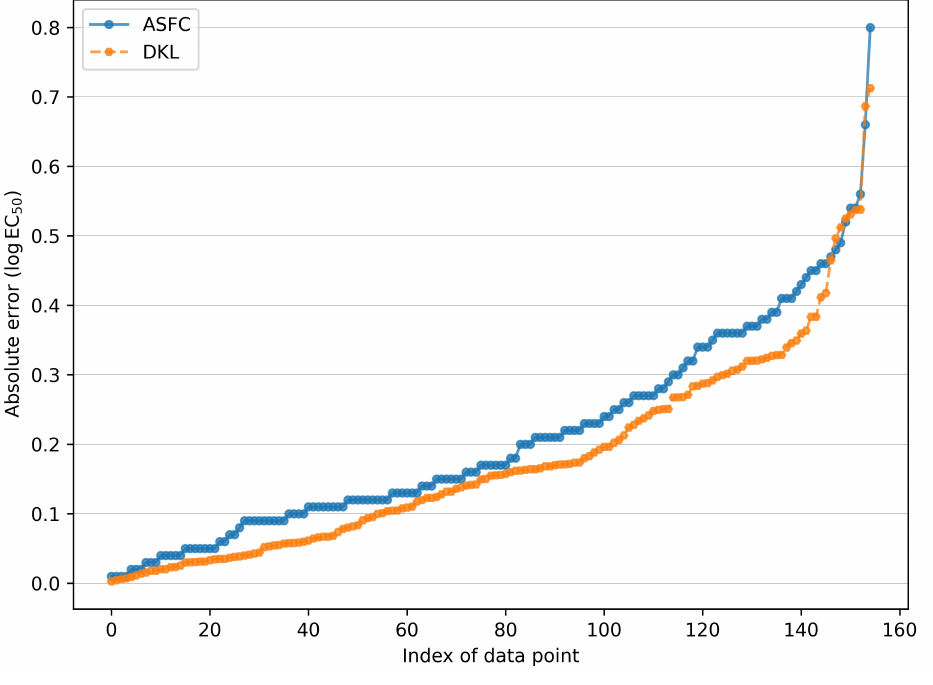
Figure 4. Sorted absolute errors between experimental and predicted logEC 50 for ASFC and DKL models on the 155 ionic liquids which form the entire